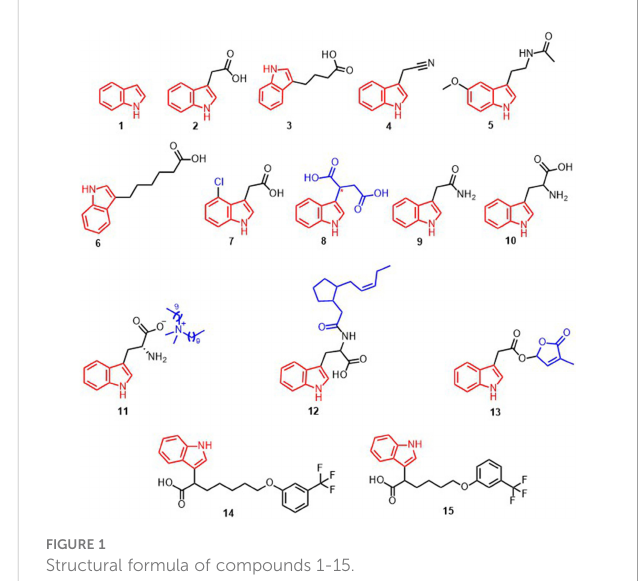
FIGURE 1 Structural formula of compounds